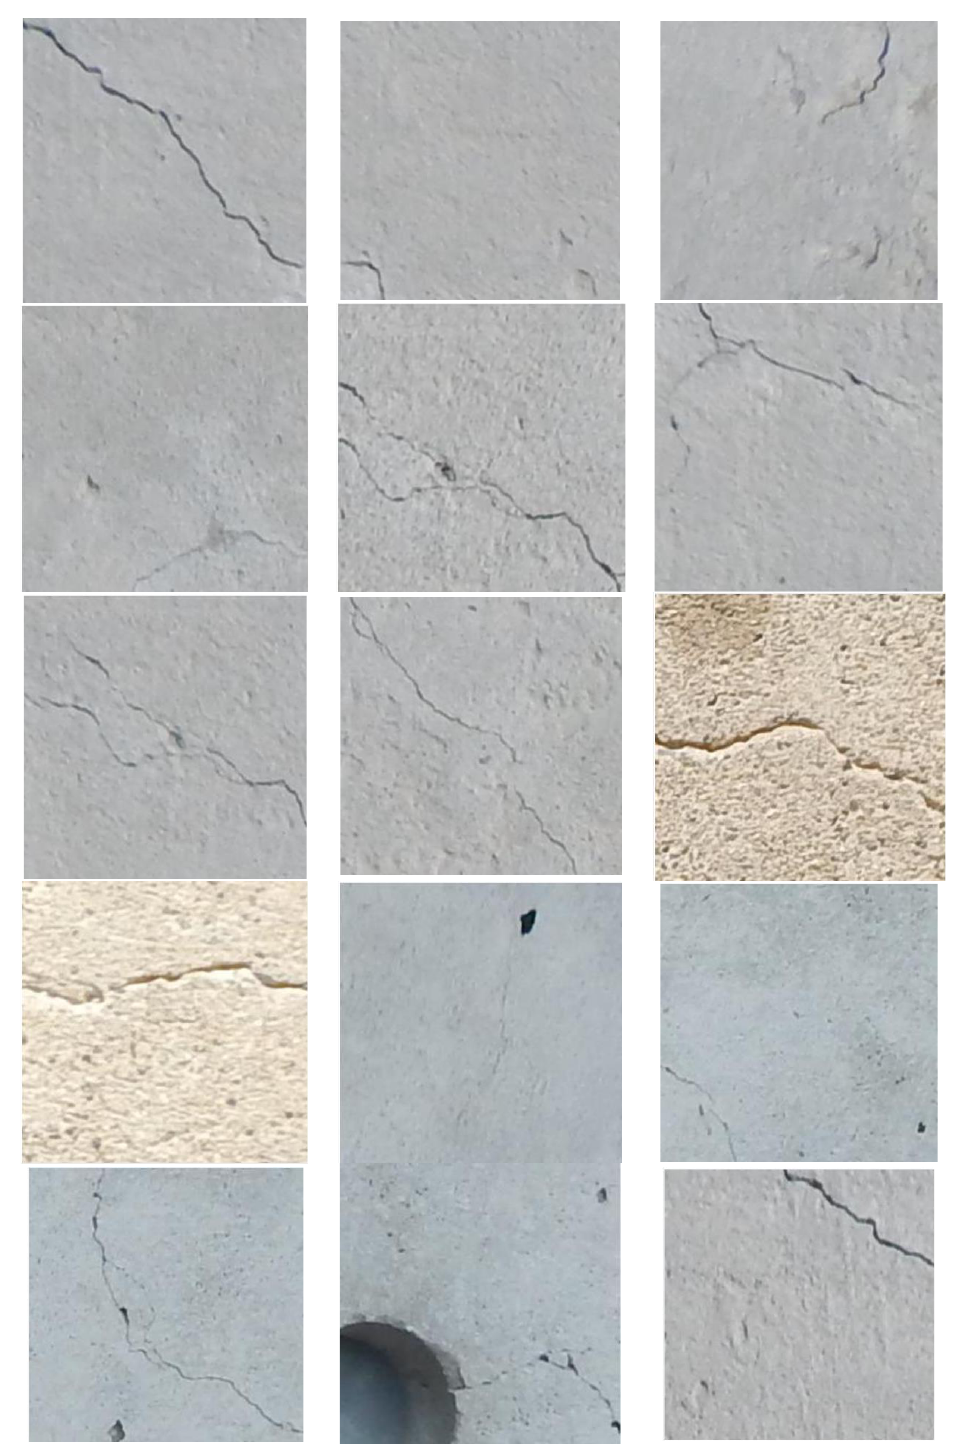
Figure 4. Wall quality dataset with cracks, holes, efflorescence, damp patches, and spall defects. The wall quality dataset was pre-trained with the ImageNet by substituting the weights and trained with convolutional neural network models, such as Conv2D Xcep- tion, DenseNet, VGG19, and ResNet models, to extract the essential features from the im- age. Equation (7) represents the Gaussian function applied for feature extraction. The pa- rameter “ r ” denotes the variance of the Gaussian function.